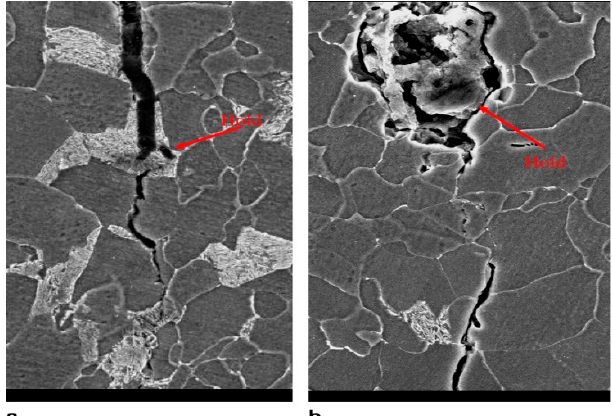
Figure 8. ( a , b ) Crack tip morphology after the pipeline specimens subjected to constant load for 7 days in different soil solutions [33]. Reproduced with permission from [33], Elsevier, 2007.